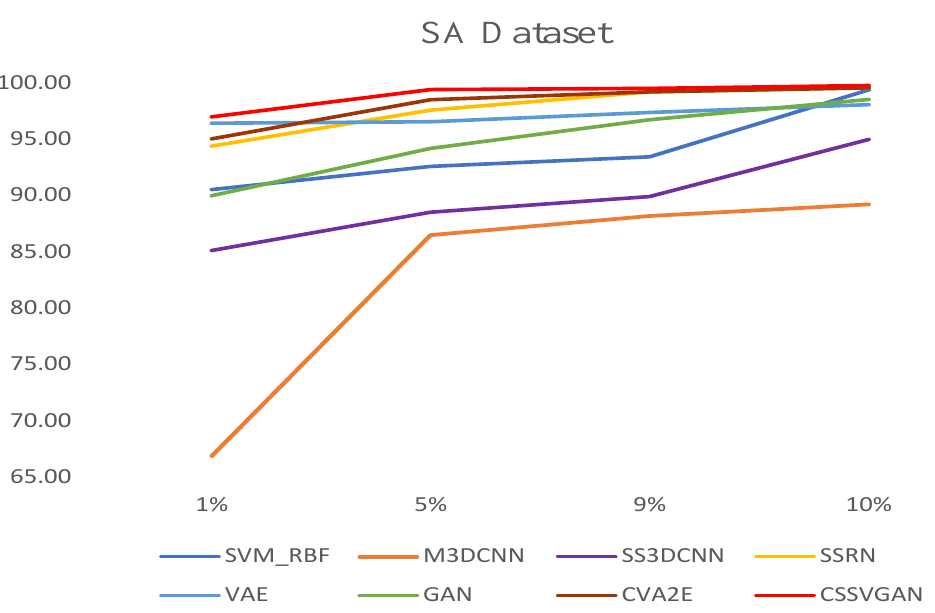
Figure 16. Sensitivity to the Proportion of Training Samples in SA dataset.